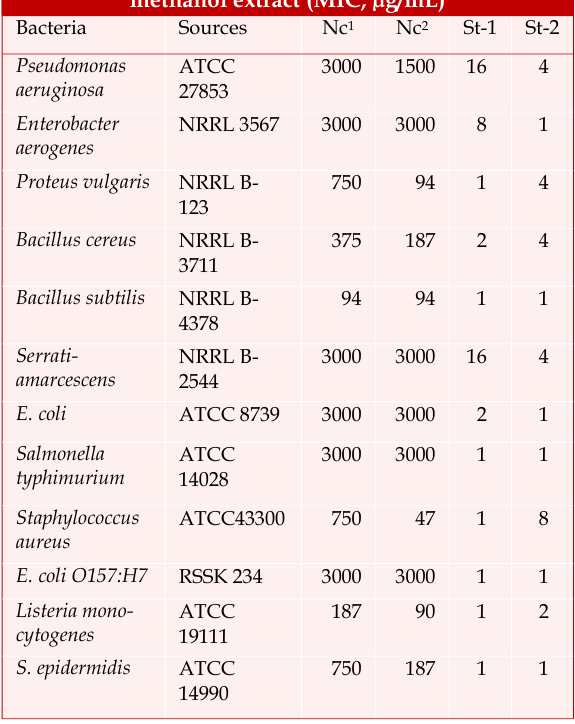
Antibacterial activity of N. cilicica essential oil and